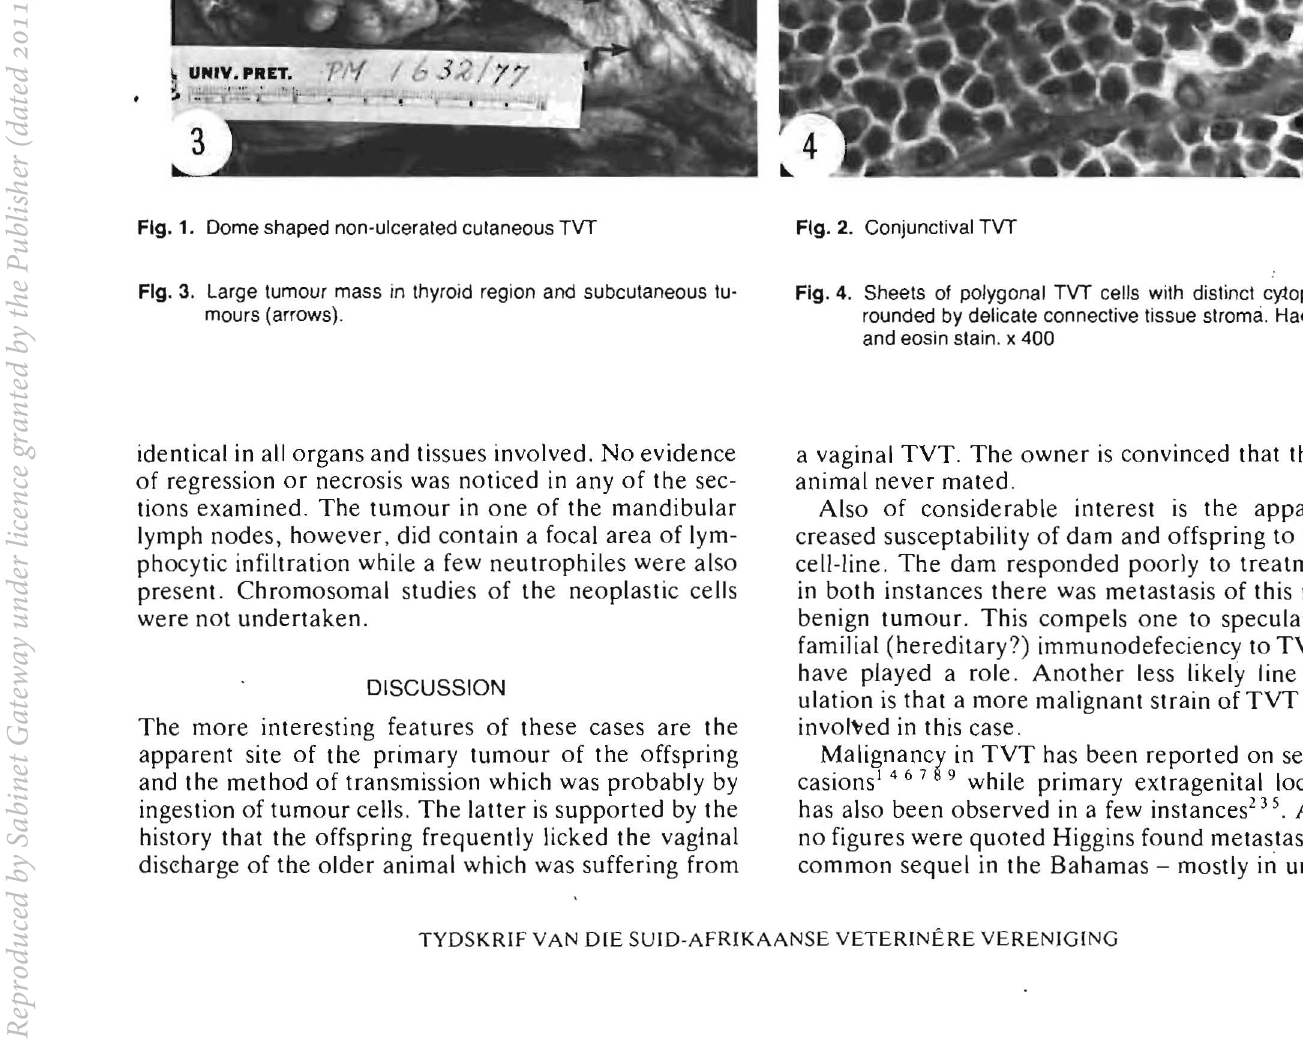
Fig. 1. Dome shaped non-ulcerated cutaneous TVT Fig. 3. Large tumour mass in thyroid region and subcutaneous tu mours (arrows).